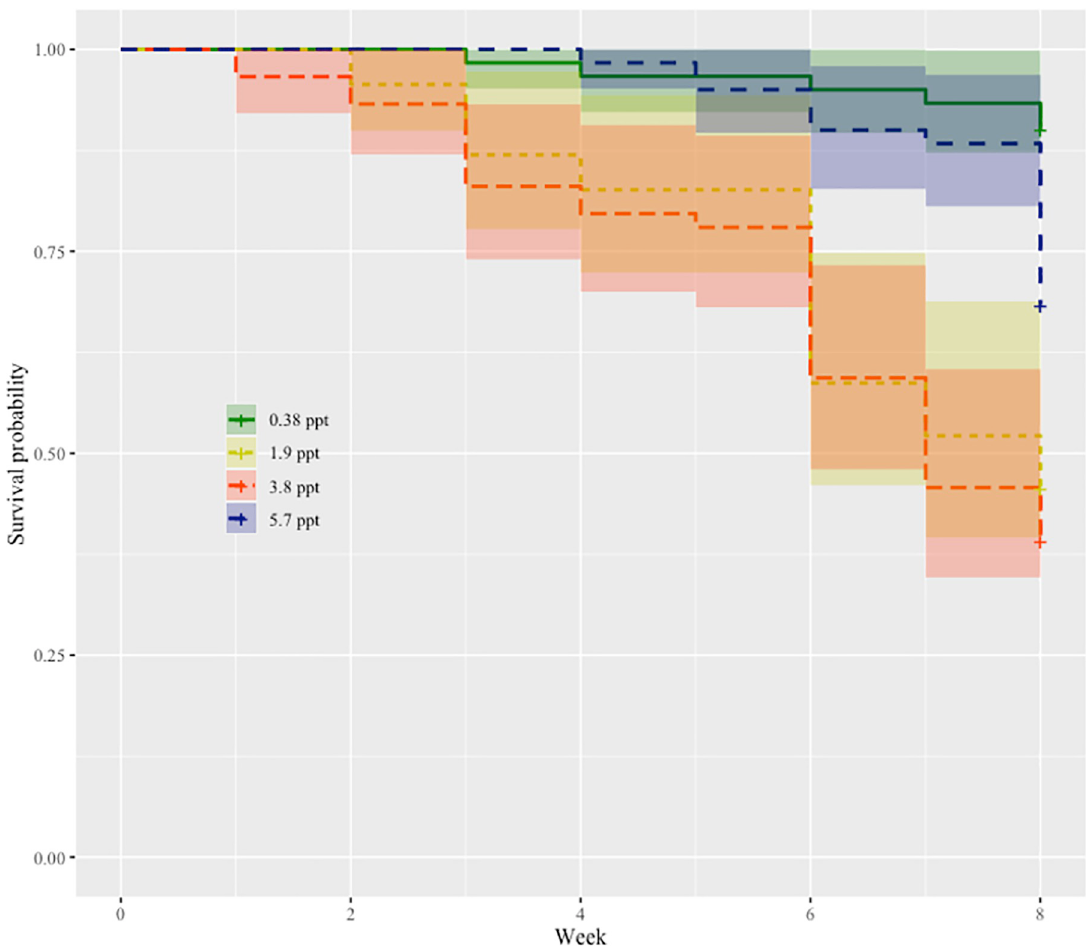
Fig 1. Probability of survival for snails in treatment groups of 0.38 ppt, 1.9 ppt, 3.8 ppt, 5.7 ppt salinity treatments. Snail survival in 0.38 ppt is significantly higher than 1.9 ppt (p < 0.05), 3.8 ppt (p < 0.0001), and 5.7 ppt (p < 0.0001). The survival probability of 1.9 ppt is significantly higher than 3.8 ppt and 5.7 ppt salinity treatments (p < 0.05). For coefficients and pairwise comparisons see supplement Table B in S1 Text